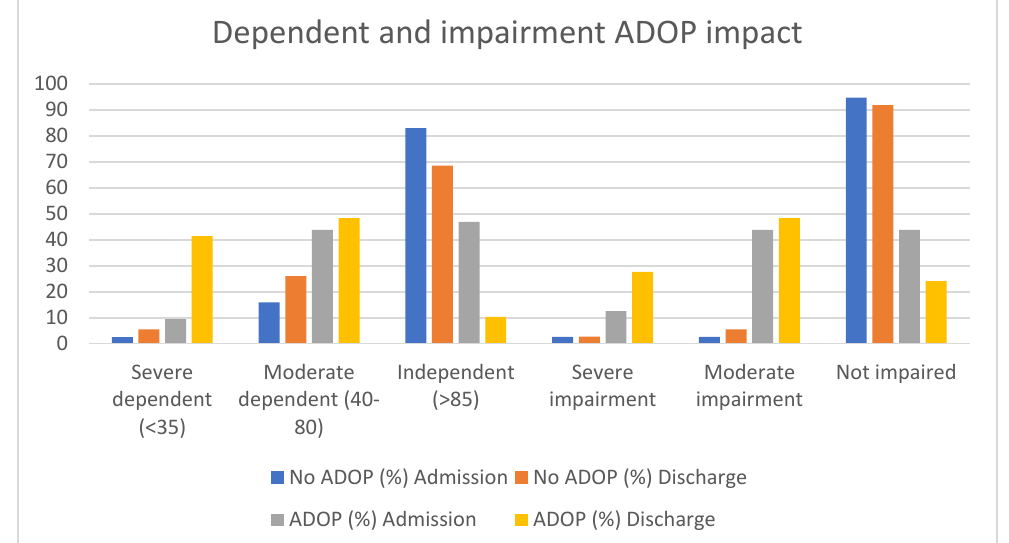
Figure 3. Early mobilization.